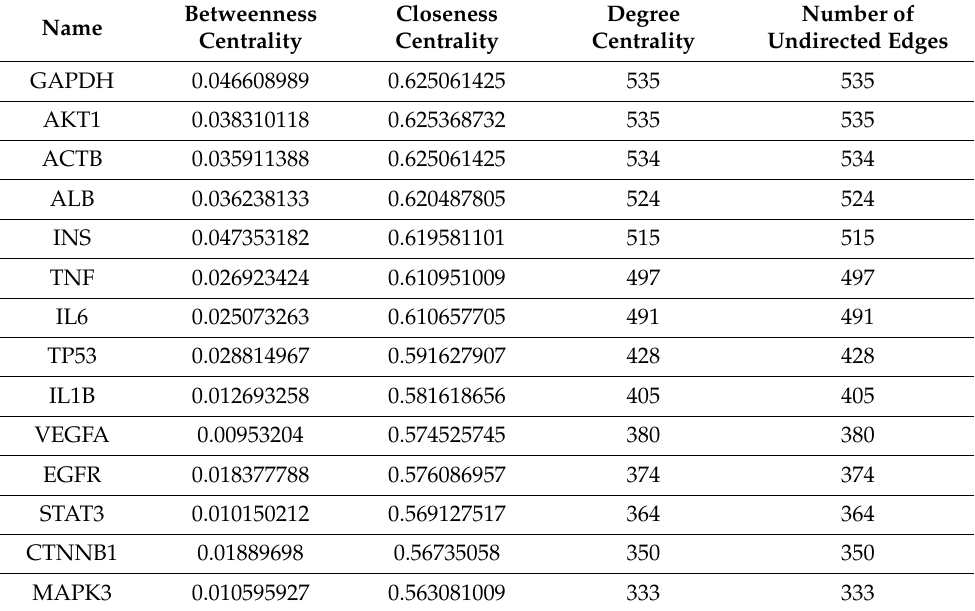
Table 4. Results from CytoNCA analysis revealing most significant target genes (selected on the basis of degree centrality).